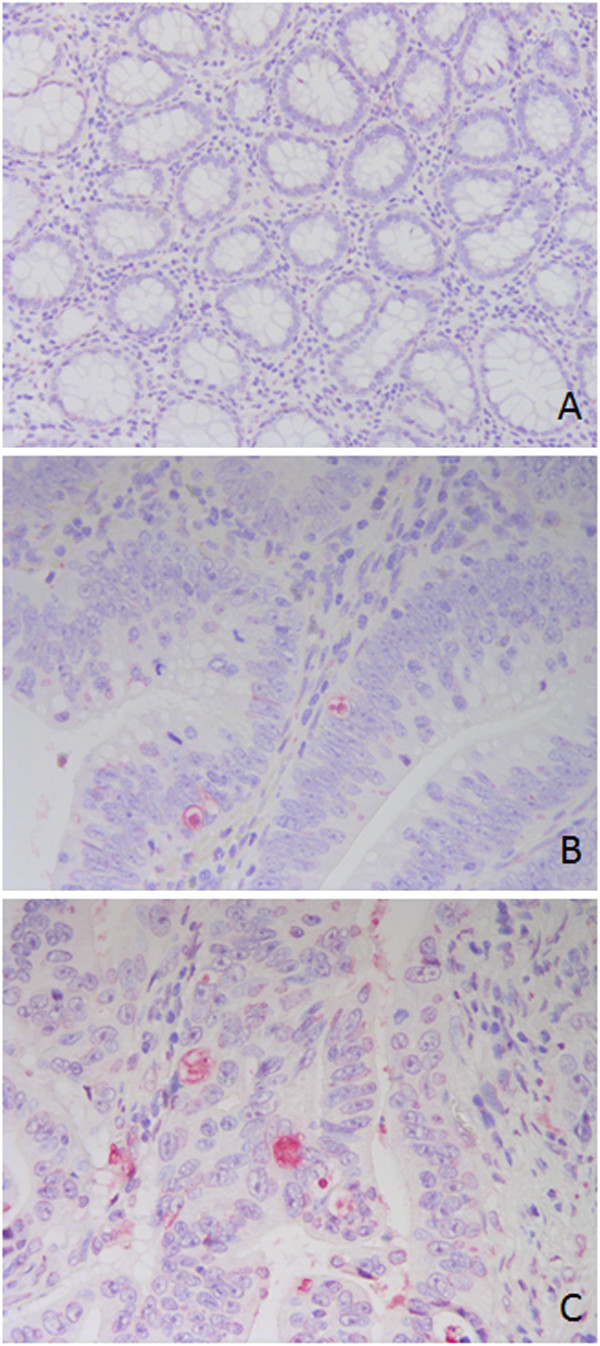
Apoptosis detected by TUNEL assay. Positively stained cells were very scarce in normal mucosa (A), increased in adenomatous polyps (B) and especially in adenocarcinomas of the colon (C). Magnification, 200x (A), 400x (B, C).